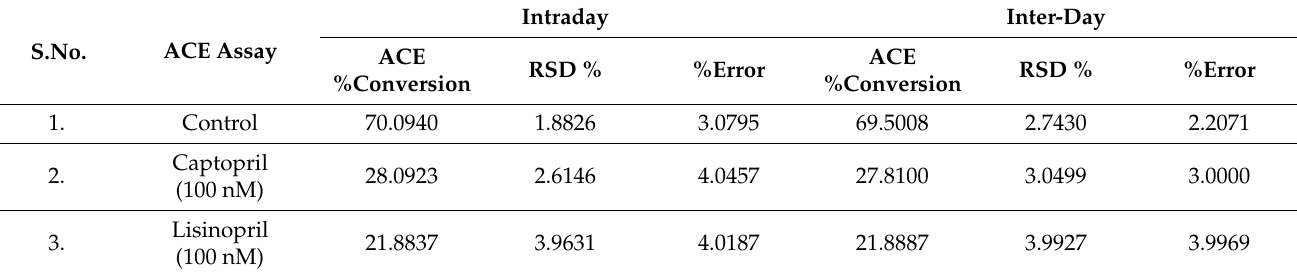
Table 2. Intraday and inter-day analysis to determine the precision and accuracy of ACE